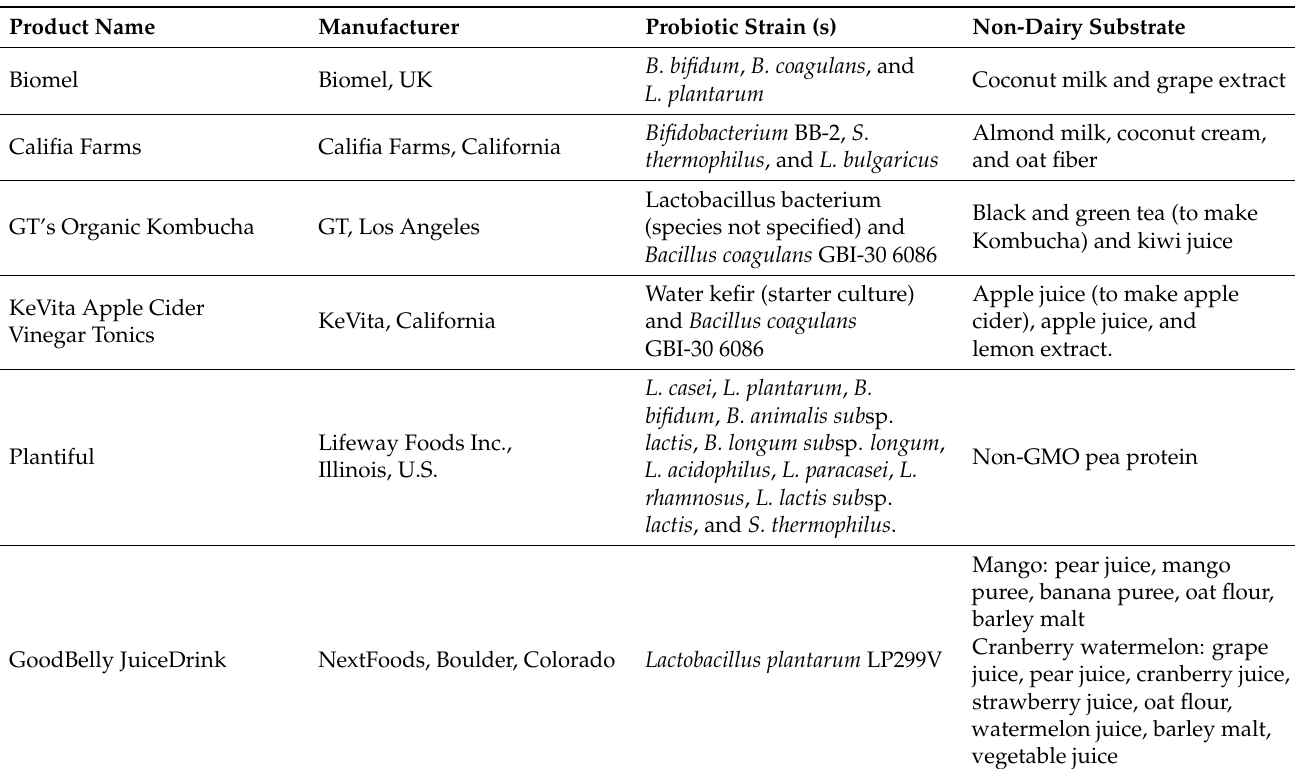
Table 2. List of non-dairy probiotic products sold